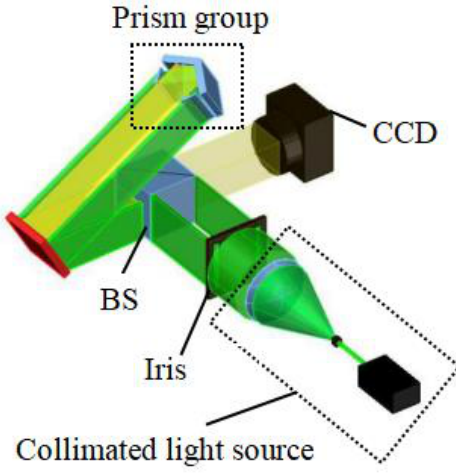
Figure 12. Diagram of the improved system by using one SLM.